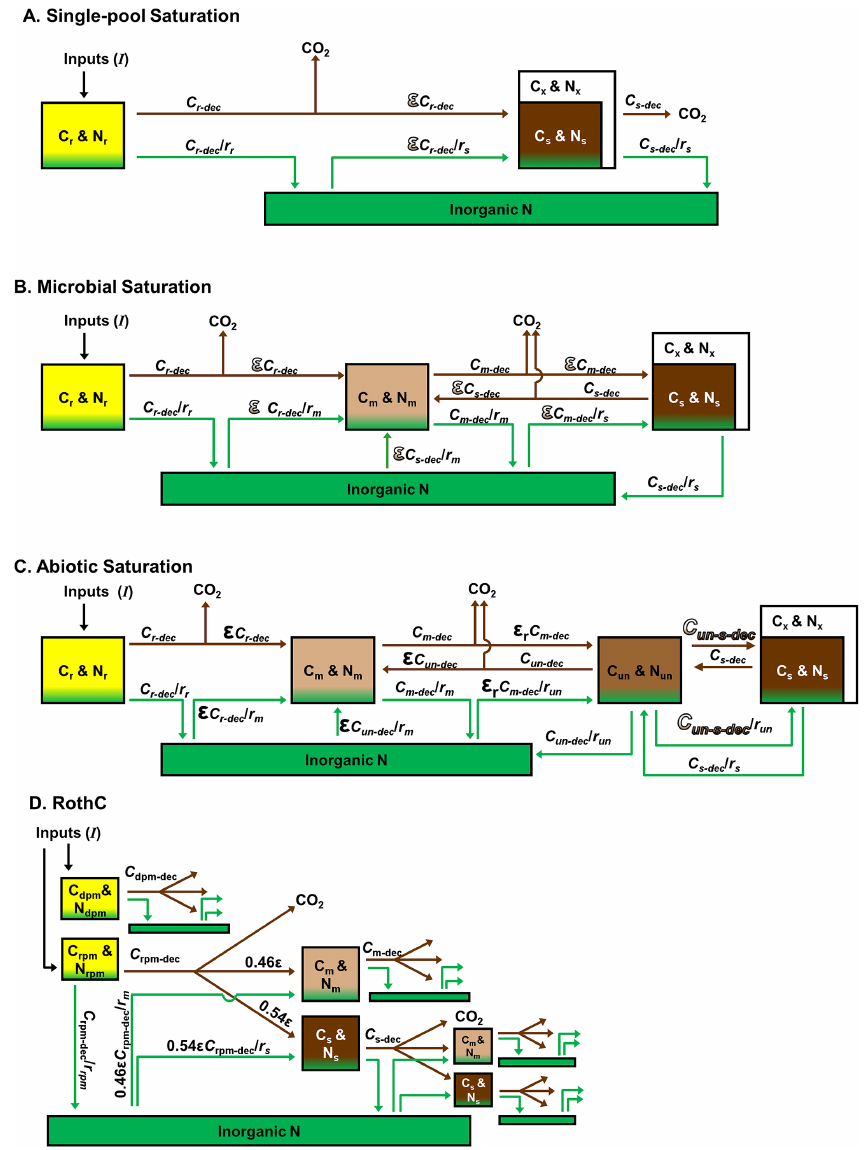
Figure 2. Diagrams of the pools and fluxes in the four models used in this study. Carbon and N pools are indicated together in boxes. Carbon fluxes are indicated by brown arrows and N fluxes by green arrows. Pools are abbreviated as follows: C r , C dpm , C rpm and N r , N dpm , N rpm are plant residues; C m and N m are microbial biomasses; C un and N un are unprotected soil organic matter; C s and N s are protected or stabilized soil organic matter; C x and N x are the maximum or saturating capacity for C and N storage. The inorganic N pool is represented by a green box. Carbon decomposition from each pool and the pool stoichiometry (C:N ratio) are represented by the symbols C j − dec and r j , respectively, where j specifies the pool. Pools decompose with first-order kinetics based on rates listed in Table 1. The symbol ε is the C transfer efficiency to the receiving pool, the value of which is specified by Table 1 for each model. Symbols illustrated with a brown gradient fill pattern are regulated by the C saturation ratio (C s /C x